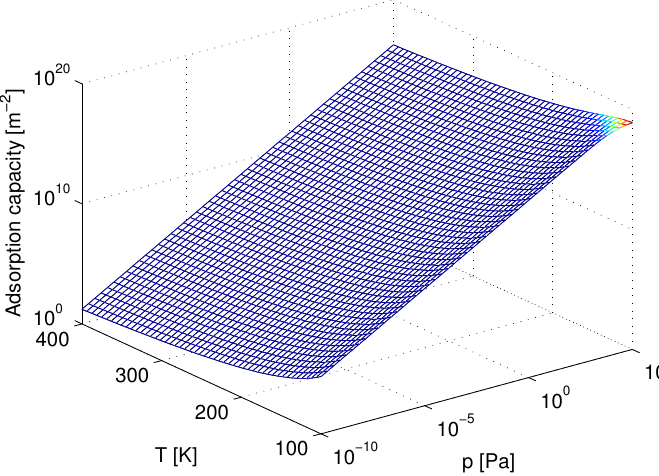
Figure 4. Adsorption capacity for carbon monoxide adsorption on